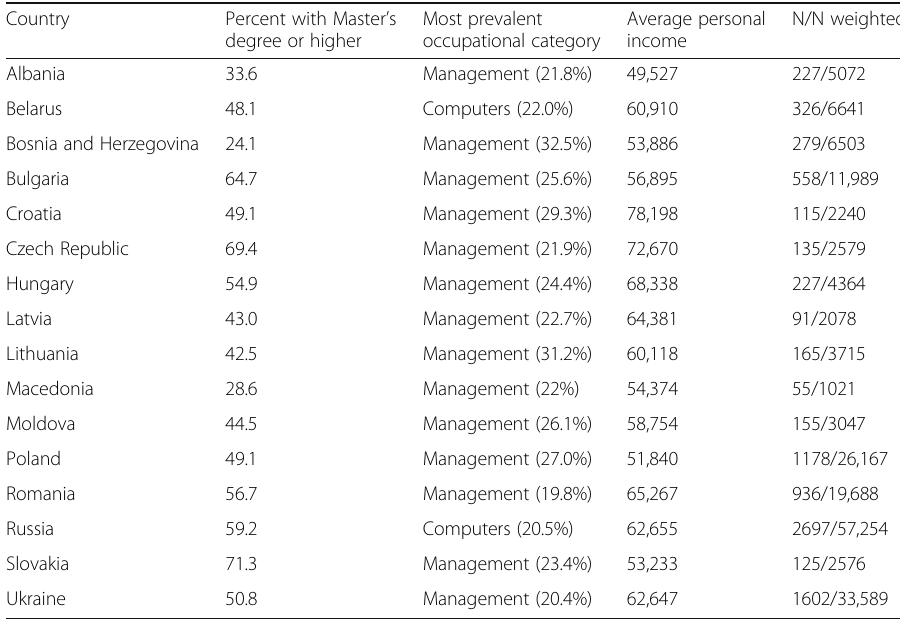
Table 8 Socioeconomic profiles of post-1991 immigrant professionals from Eastern Europe by country of origin, 2006 – 2009 ACS Country Percent with Master ’ s Most prevalent degree or higher occupational category